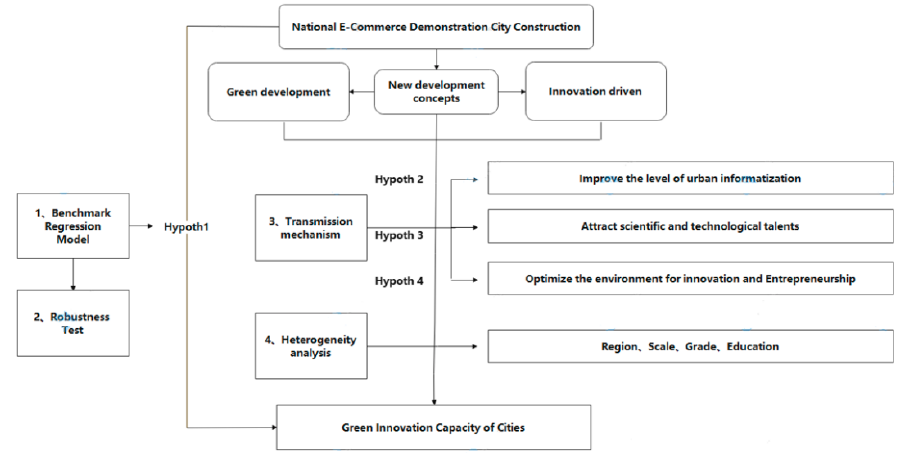
Figure 1. Analysis